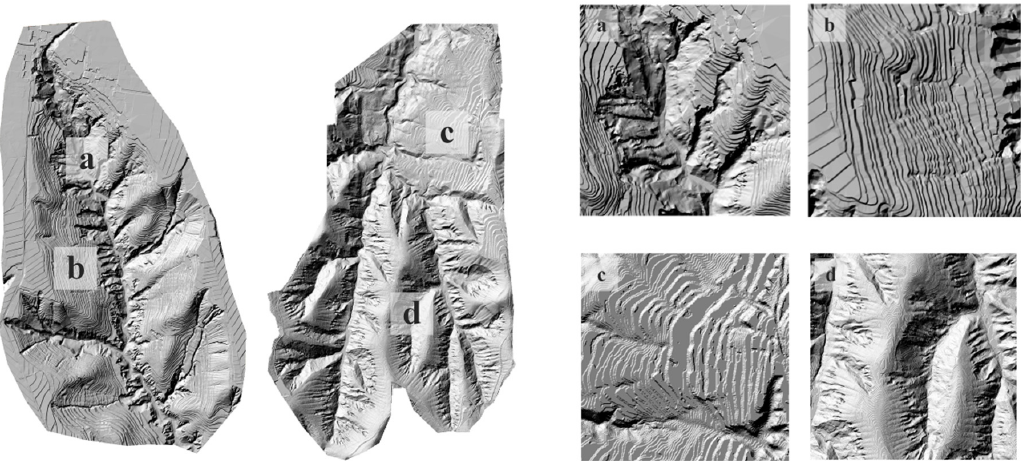
Figure 5. Shaded relief images of the digital terrain models (DEMs) for: Changwu ( left ); and Ansai ( right ).